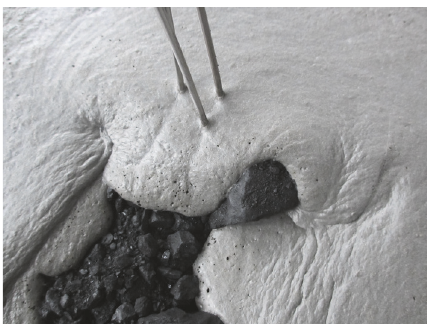
Figure 6: Condensation effect of a fluid penetration diffusion front in the coal and rock surface after 3 hours.